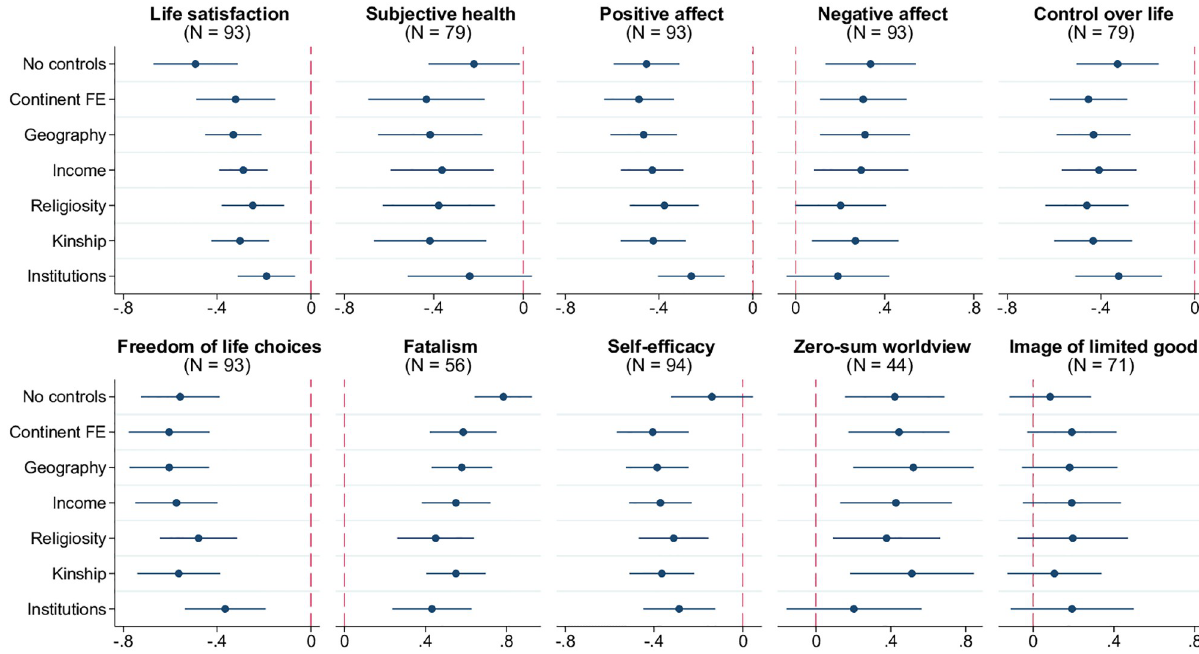
Fig 6. Witchcraft beliefs, anxiety, and worldview. Each panel of the figure presents the results of estimating 7 different models, in which the metric of anxiety or worldview indicated in the panel title is regressed on the prevalence of witchcraft beliefs, along with a set of control variables. The latter is defined as follows according to the tickmarks on the vertical axis: 1) none for “No controls”, 2) only continental fixed effects for “Continent FE”, 3) continental fixed effects and baseline geographic controls (absolute latitude, terrain ruggedness, agricultural suitability of land, distance to the coastline) for “Geography.” The remaining 4 models, named “Income,” “Religiosity,” “Kinship,” and “Institutions” include, respectively, real GDP per capita, average religiosity, kinship intensity index, and the rule-of-law index (in addition to continental fixed effects and geographic variables). The round marker represents the point estimate for the coefficient on the prevalence of witchcraft beliefs, and the linear segment around each marker is the respective 95% confidence interval based on heteroskedasticity-robust standard errors. Sample size N indicated in parentheses. The key variables are standardized to have zero mean and unit standard deviation in relevant